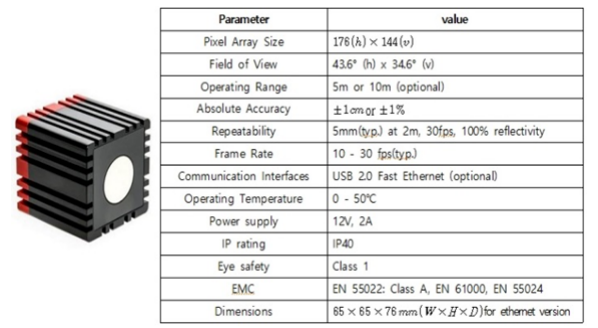
Table 1. MESA SR4000 Specification